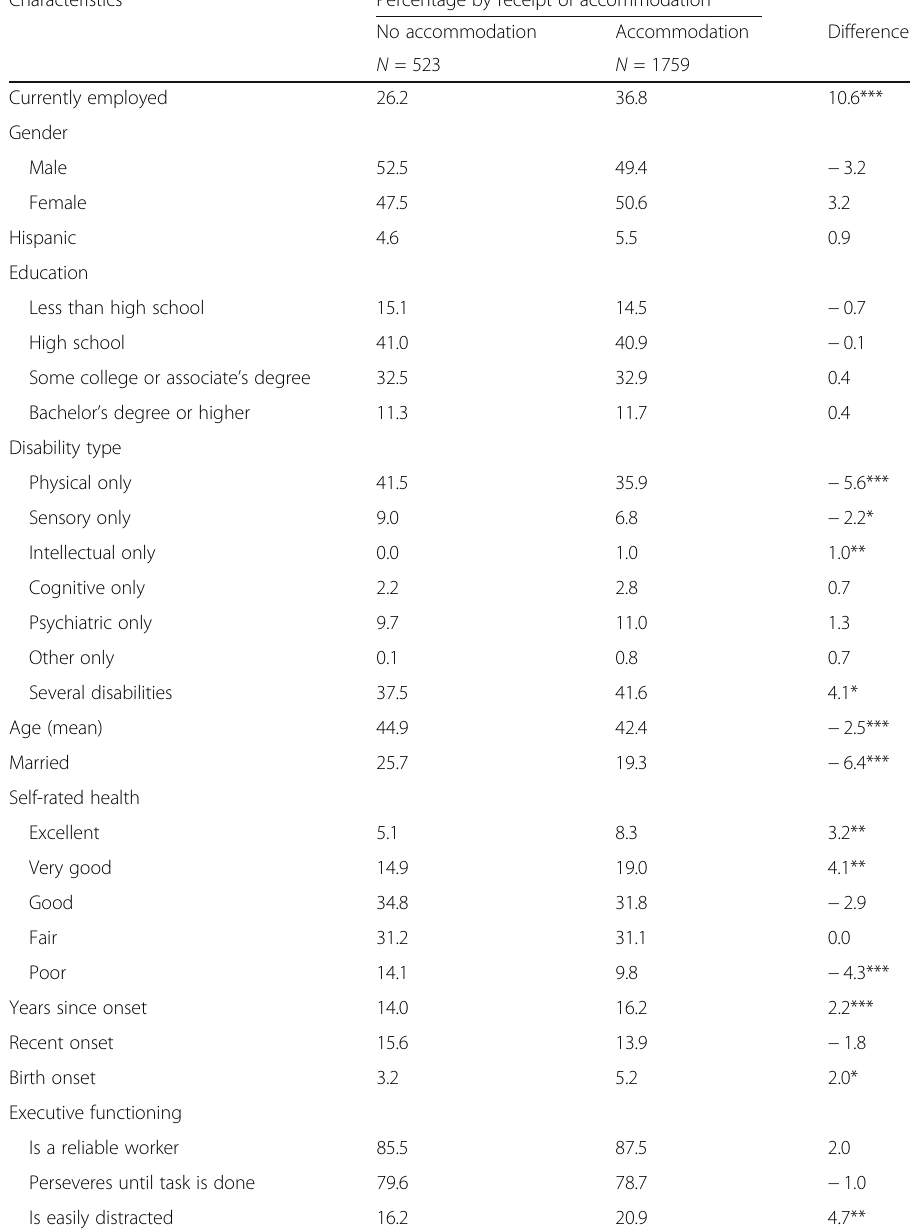
Table 5 Individual characteristics by receipt of workplace accommodations in current or last job